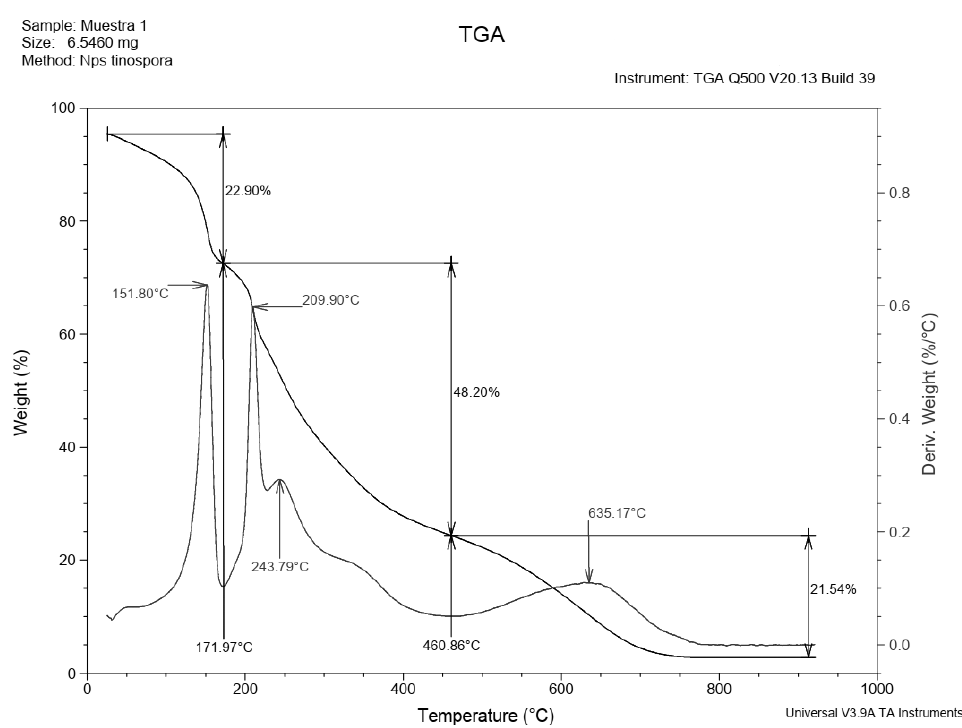
Figure 6. TGA of the EPS produced by the BU-4 isolate in glucose-based medium.